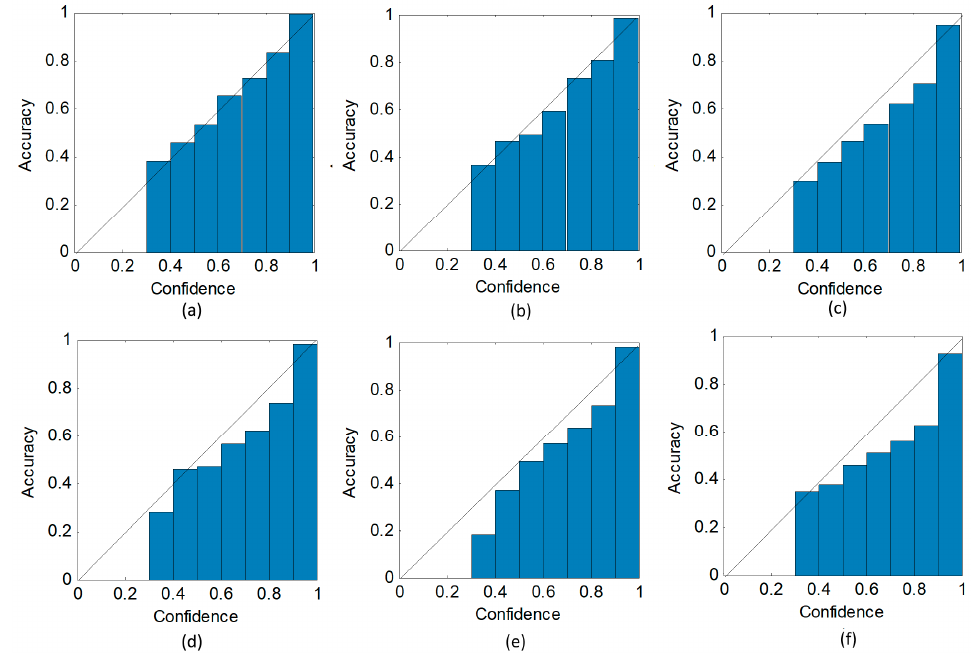
Figure 13. Reliability diagrams of ( a ) our model with 100% data, ( b ) our model with 50% data, ( c ) our model with 10% data, ( d ) PPA with 100% data. ( e ) PPA with 50% data, ( f ) PPA with 10% data.